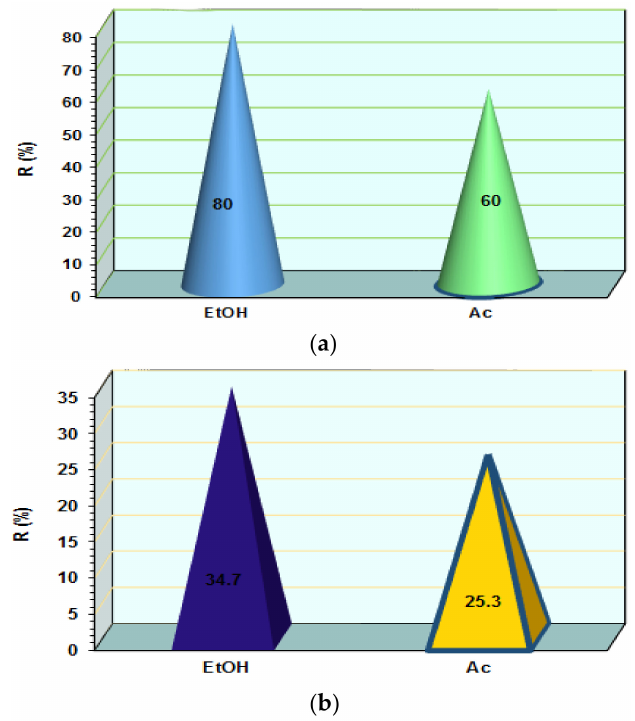
Figure 5. Effect of EtOH and Ac on the AB 113 recovery from XAD7HP ( a ) and MS ( b